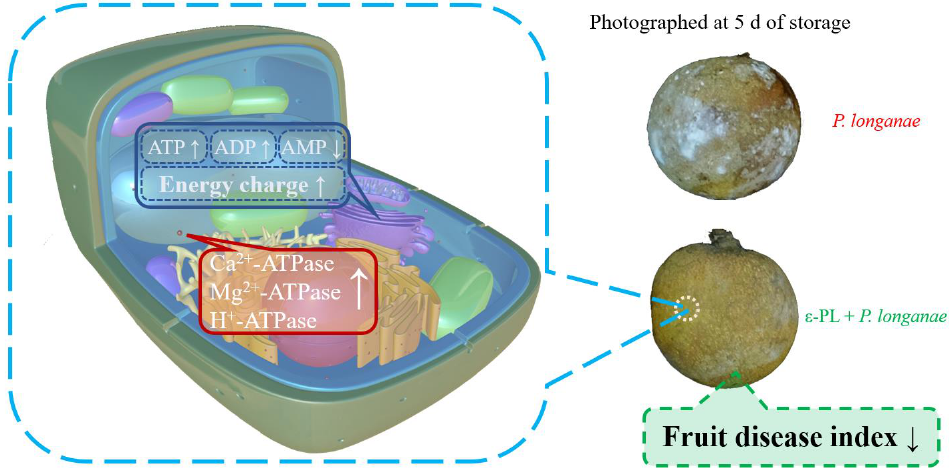
Figure 6. The possible mechanism of ε -PL reduces the incidence of P. longanae infection in harvested longan fruit via acting on energy metabolism.